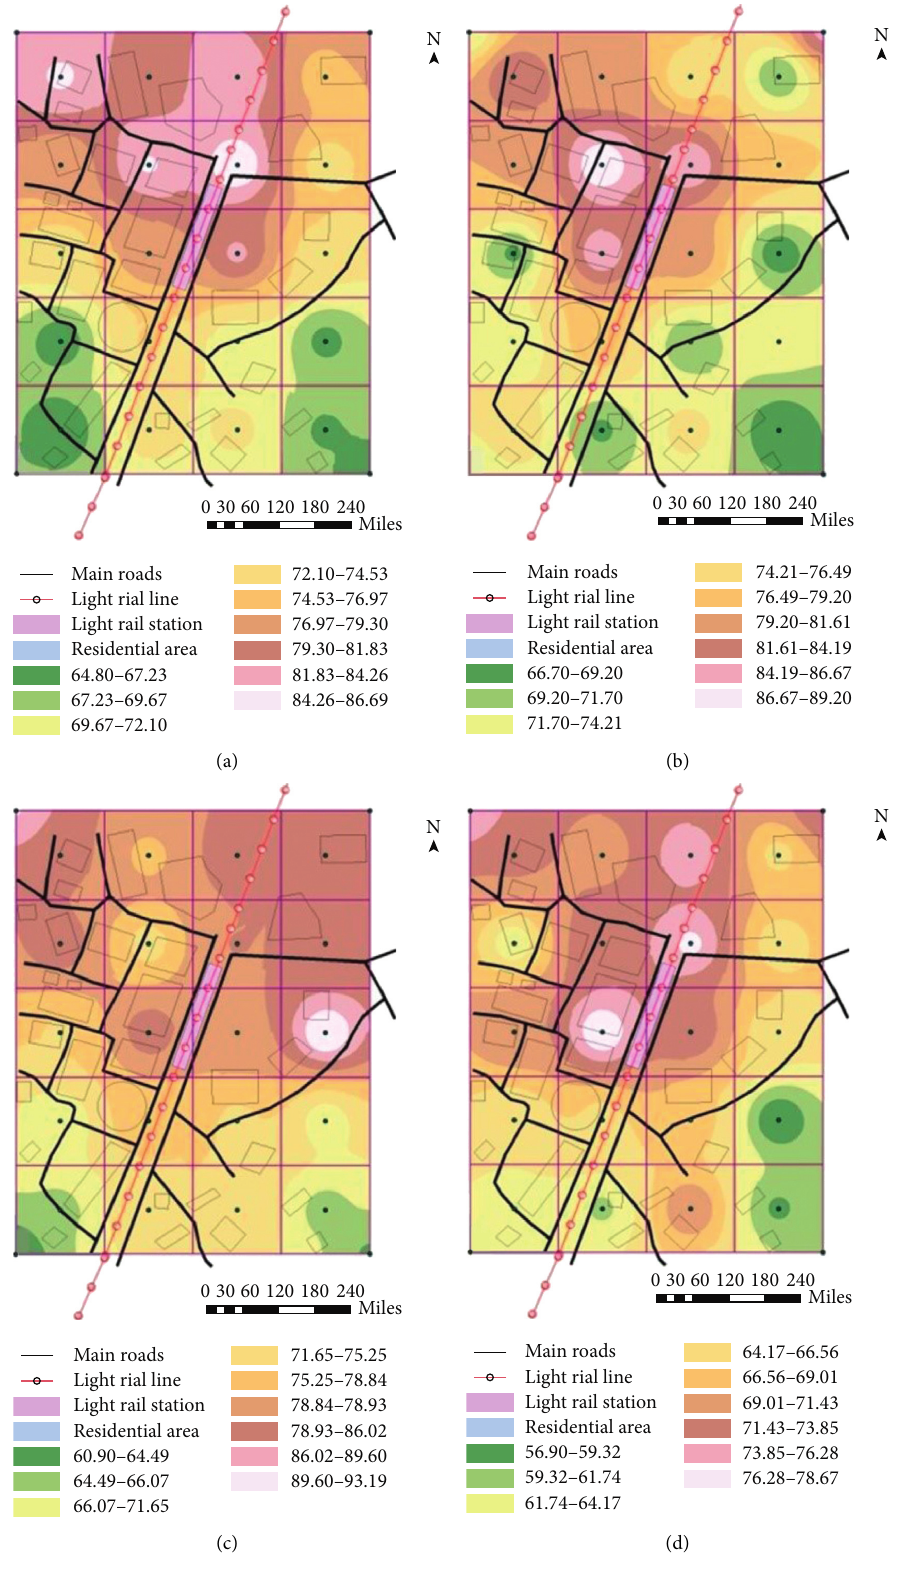
Figure 12: The acoustic environment for Thursday. (a) 7:00 a.m. (b) 12:00 p.m. (c) 06:00 p.m. (d) 10:00